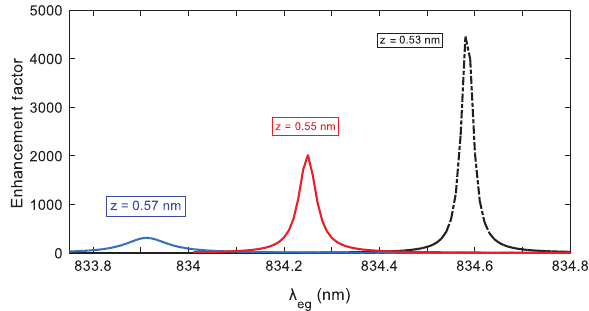
Figure 4: Exact solutions of the 3D Maxwell